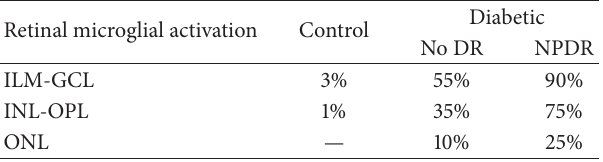
Table 1: The percentage of eyes with hyperreflective spots.